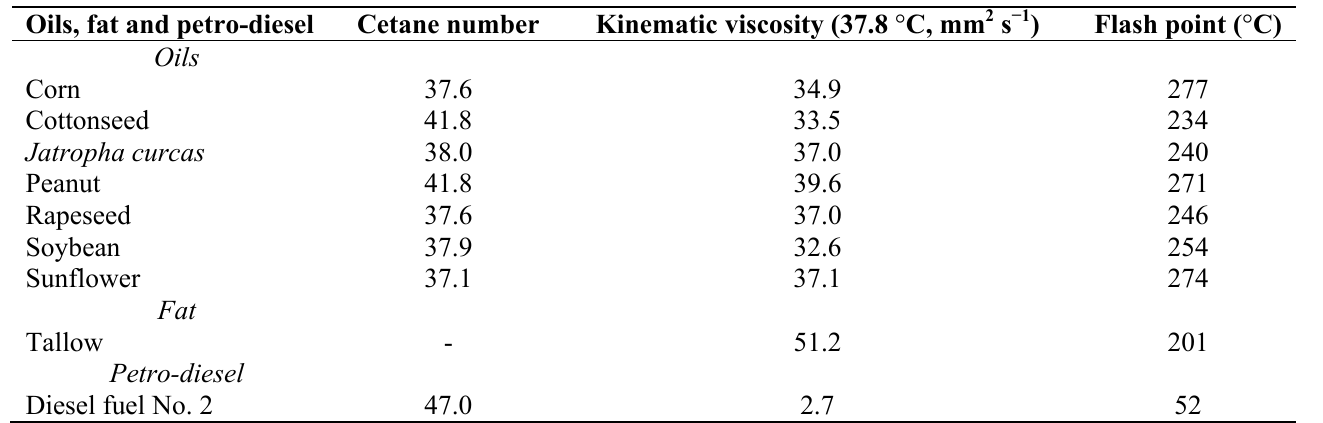
Table 3. Physical properties of oils, fat and petro-diesel